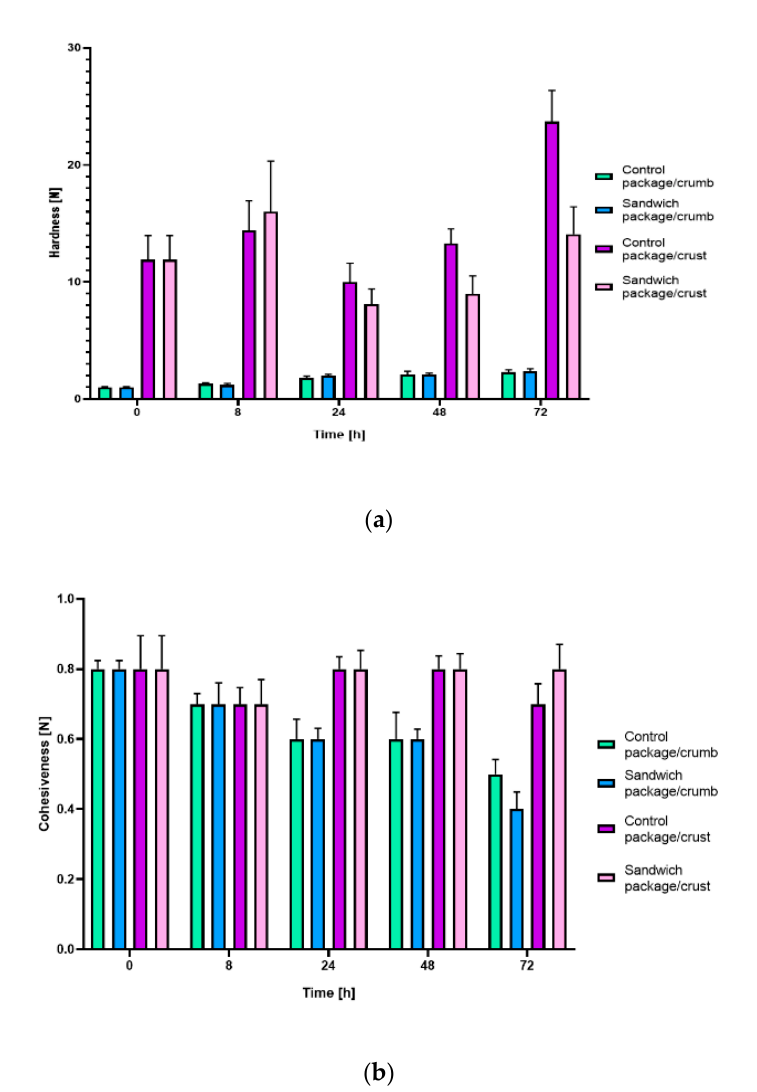
Figure 4. ( a ) Hardness of the crust and crumb after storage in paper and in the modified package. ( b ) Cohesiveness of the crust and crumb after storage in paper and in the modified package.